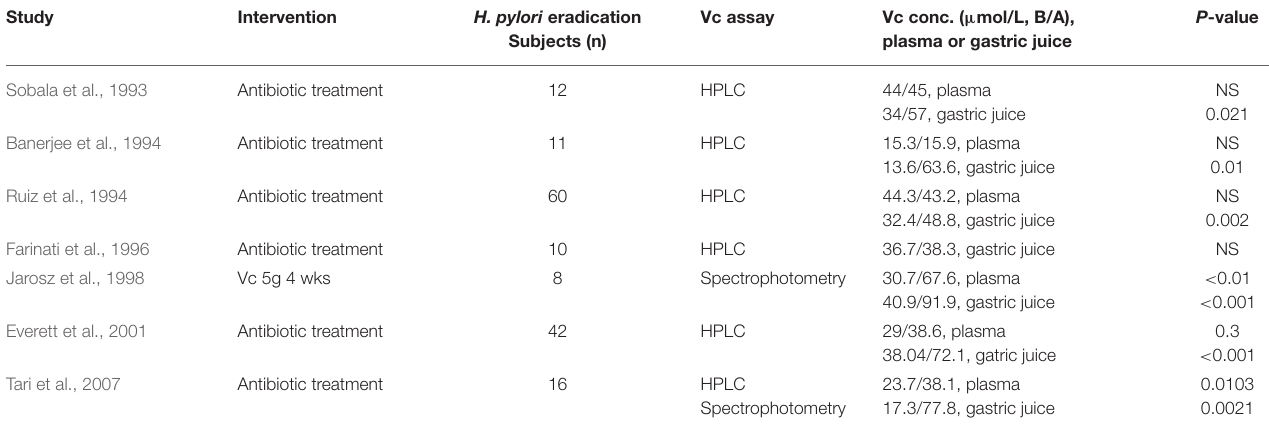
TABLE 2 | Effect of H. pylori eradication on vitamin C concentration in gastric juice and plasma.